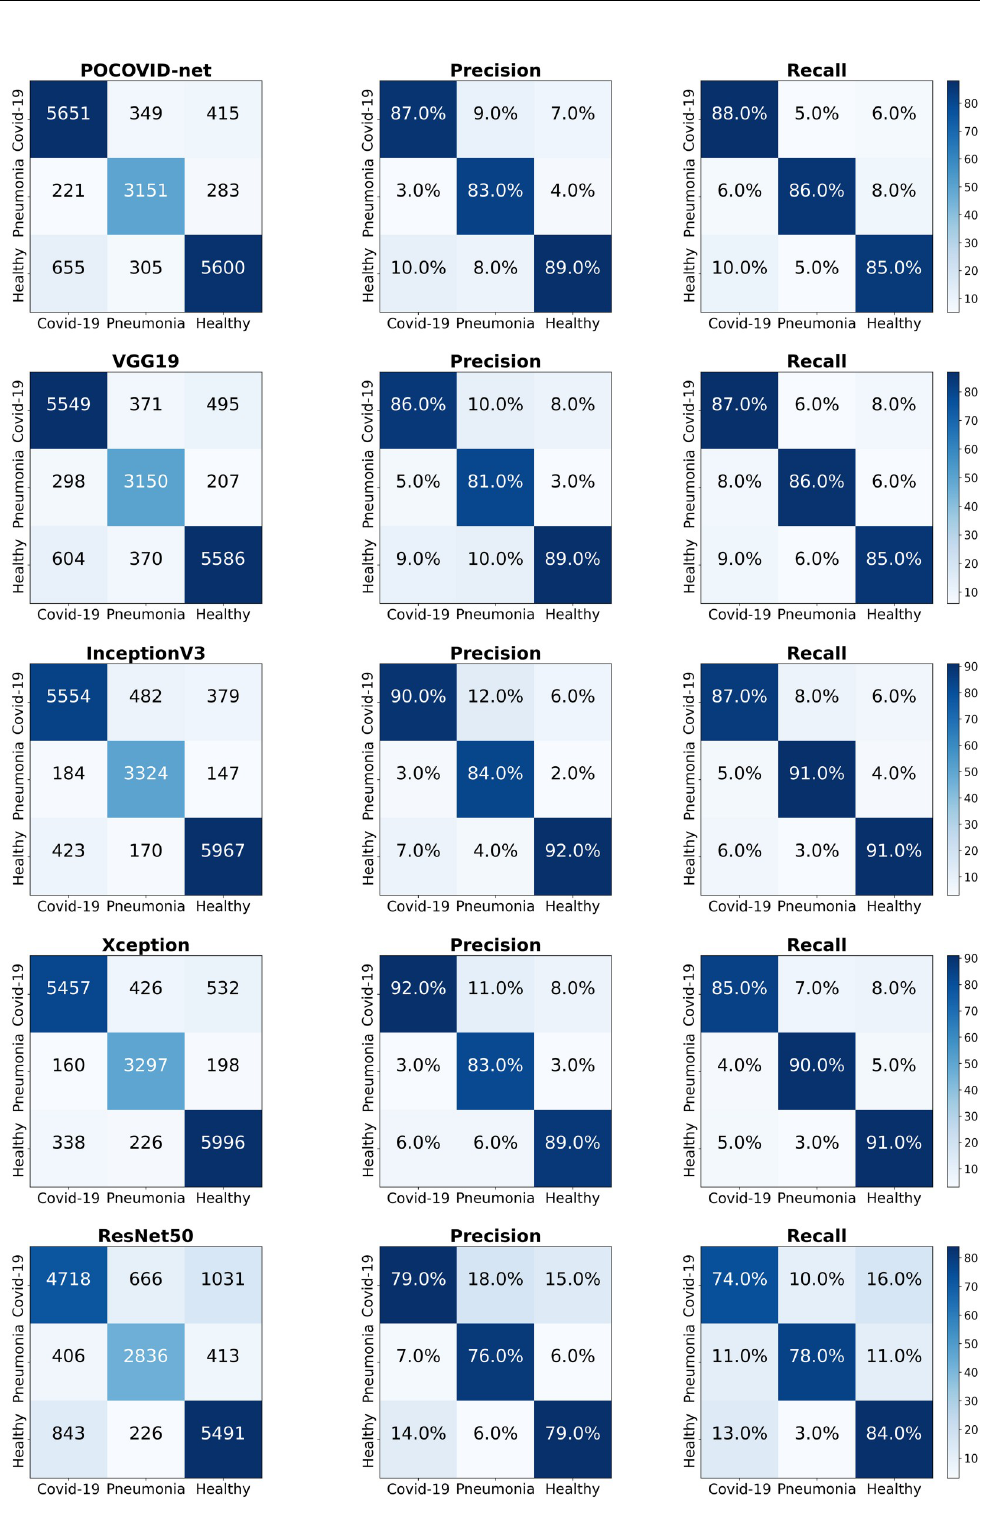
Fig 4. 5 × 5-fold cross-validation results: Confusion